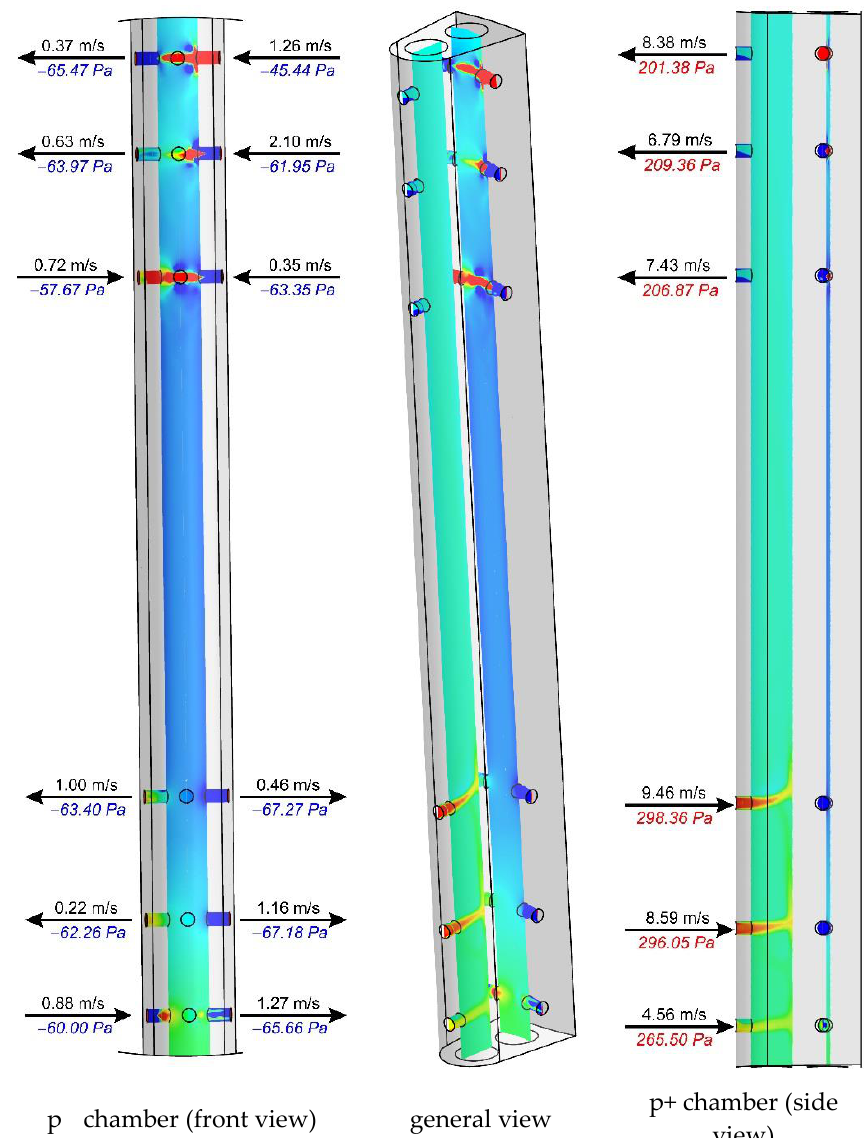
Figure 11. Fluid velocity and total pressure in planes of bore holes downstream of an elbow (x / D = 3) with radius of curvature R c = 1D.